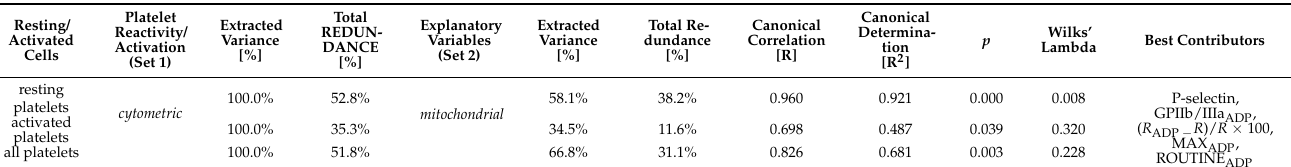
Table 6. Canonical correlations between two sets of parameters: flow cytometry markers of platelet activation and parameters of platelet mitochondrial